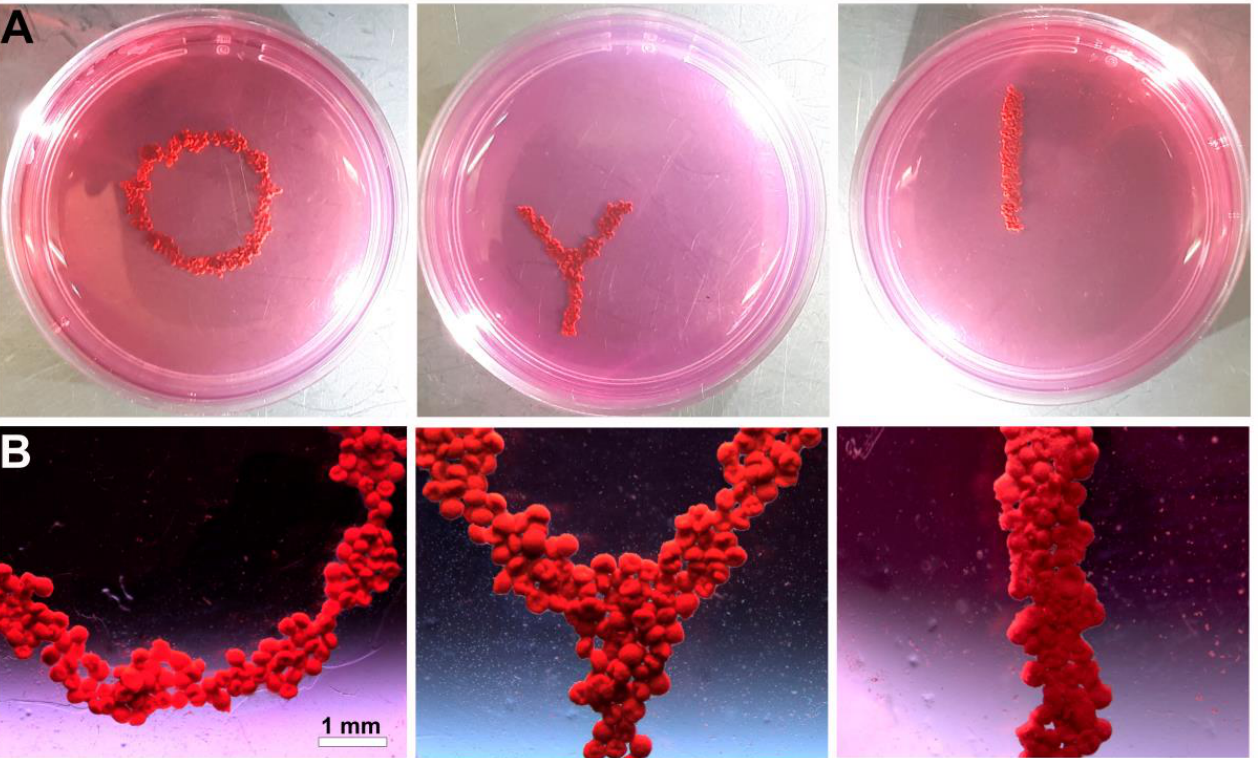
Figure 7. Forming circular, branched, and linear constructs by magnetic patterning of tissue spheroids labeled with magnetic nanoparticles. ( A ) Photographs and ( B ) stereo images of tissue constructs.